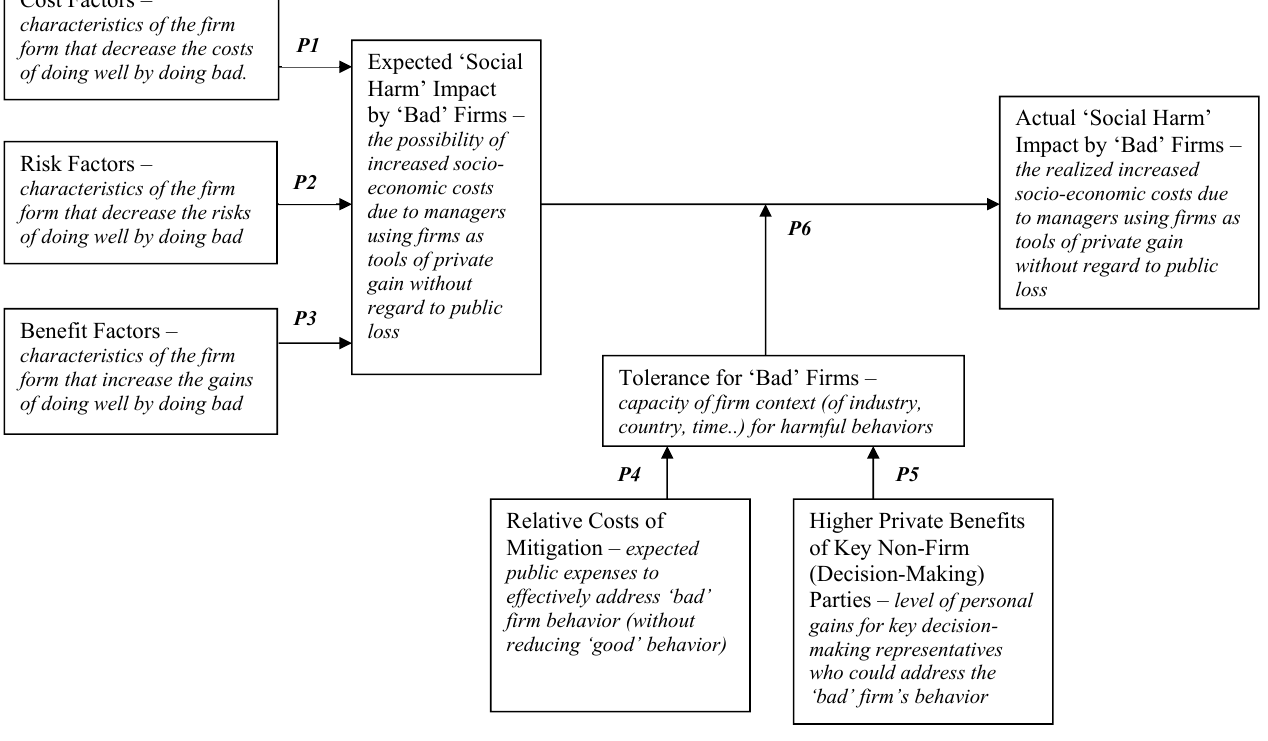
Figure 1. Mapping of the